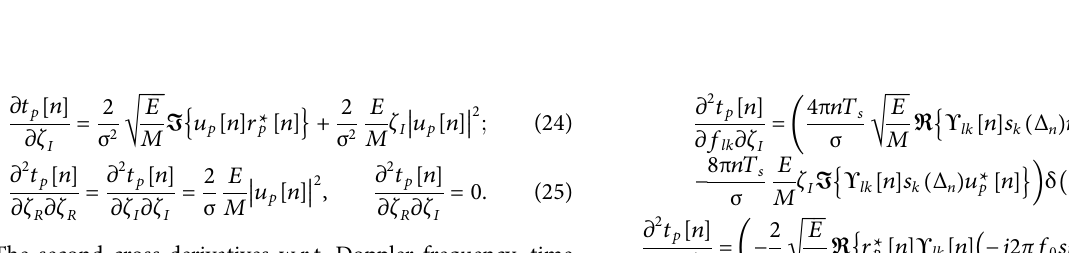
FIGURE 10 | CRLBs vs. ρ , Clutter Model II for 45 ° shifted TX/RX antennas with ] = 2.1, SCR = 0 dB , and v x = v y = 50 m/s.